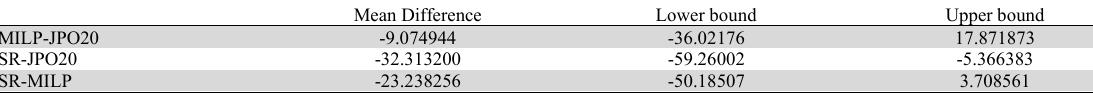
Tukey HSD 95% confidence of average RDI values for TF and RDD.